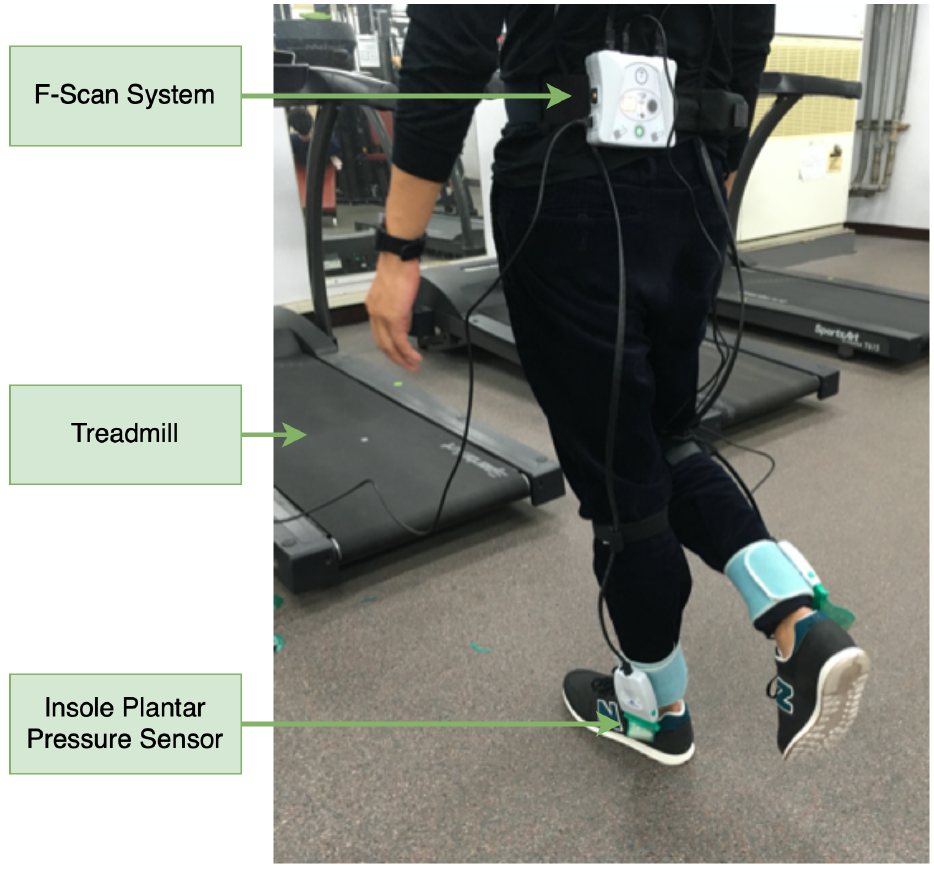
Figure 1. Illustration of a self-selected speed plantar pressure video collection